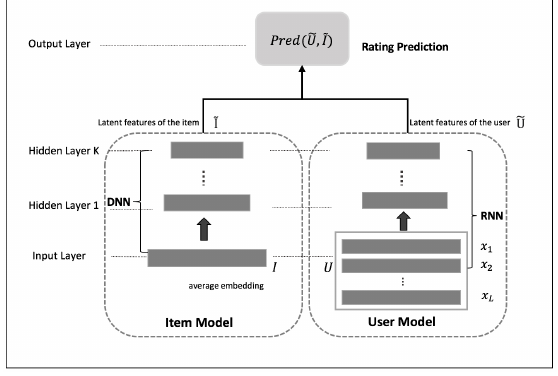
Figure 1. The overview of proposed model.